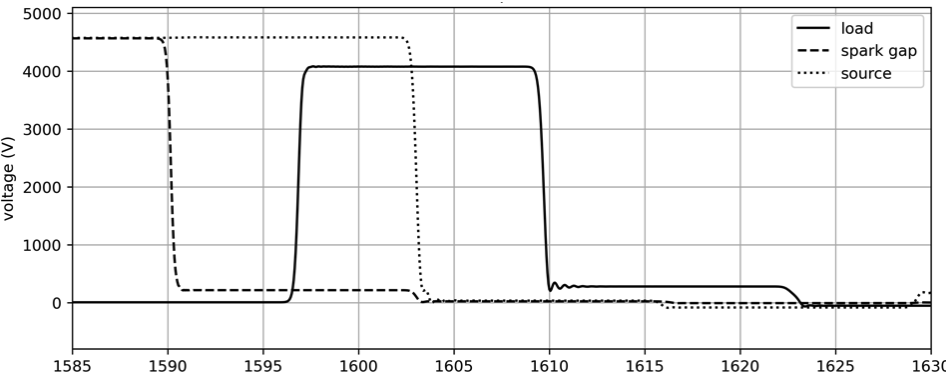
Figure 6. Voltages across the matched load, the spark-gap (a time-varying resistor) and the high voltage DC power